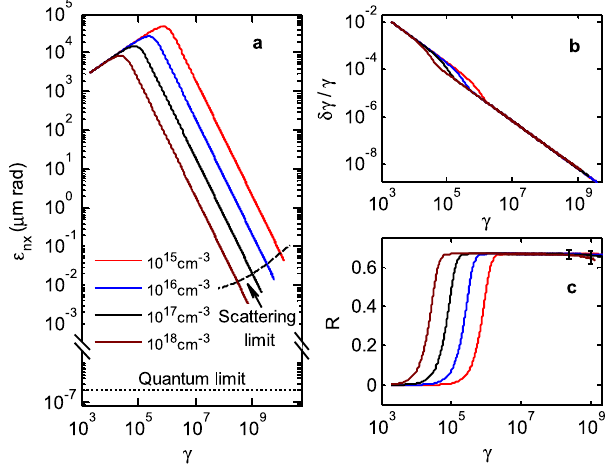
FIG. 4. Evolutions of (a) normalized transverse emittances " , (b) energy spreads (cid:11)(cid:8)=(cid:8) , and (c) relative radiation loss nx rate R of electron beams with different plasma densities of 10 15 cm (cid:1) 3 (red lines), 10 16 cm (cid:1) 3 (blue lines), 10 17 cm (cid:1) 3 (black lines), 10 18 cm (cid:1) 3 (brown lines), respectively, as a function of the beam energy (cid:8) . The black dashed line and dotted line indicate of normalized transverse emittance the equilibrium value " n EQ with the growth due to the multiple Coulomb scattering on ¼ (cid:3) - = 2 plasma ions and the minimum normalized emittance " n with the Compton wavelength (cid:3) - deduced from the uncertainty principle, respectively. The initial conditions and the wakefield parameters are the same as those of Fig. 1. The error bars shown in (c) are estimated around (cid:8) ’ 10 9 from the numerical error of the 4th-order Runge-Kutta algorithm. The numerical errors of relative radiation loss rate R around (cid:8) ’ 10 9 in the cases of 10 15 cm (cid:1) 3 , 10 16 cm (cid:1) 3 , 10 17 cm (cid:1) 3 , and 10 18 cm (cid:1) 3 are 0.18%, 0.36%, 1.08%, and 3.25%,